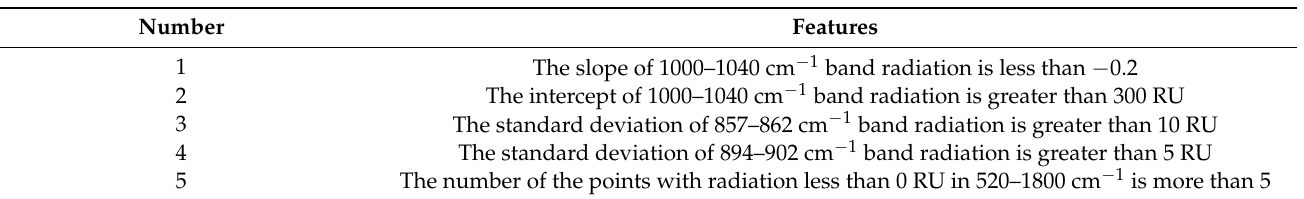
Table 1. Spectral features of obvious outliers corresponding to gray background parts in Figure